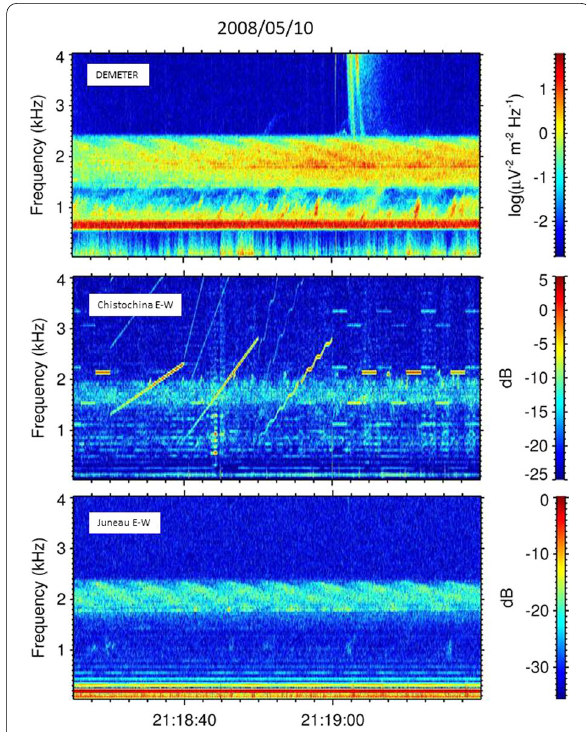
Fig. 26 Zoom of Fig. 25 between 21:18:25 and 21:19:20 UT in the frequency range 0–4 kHz. The power spectral density is color-coded according to the scale on the right